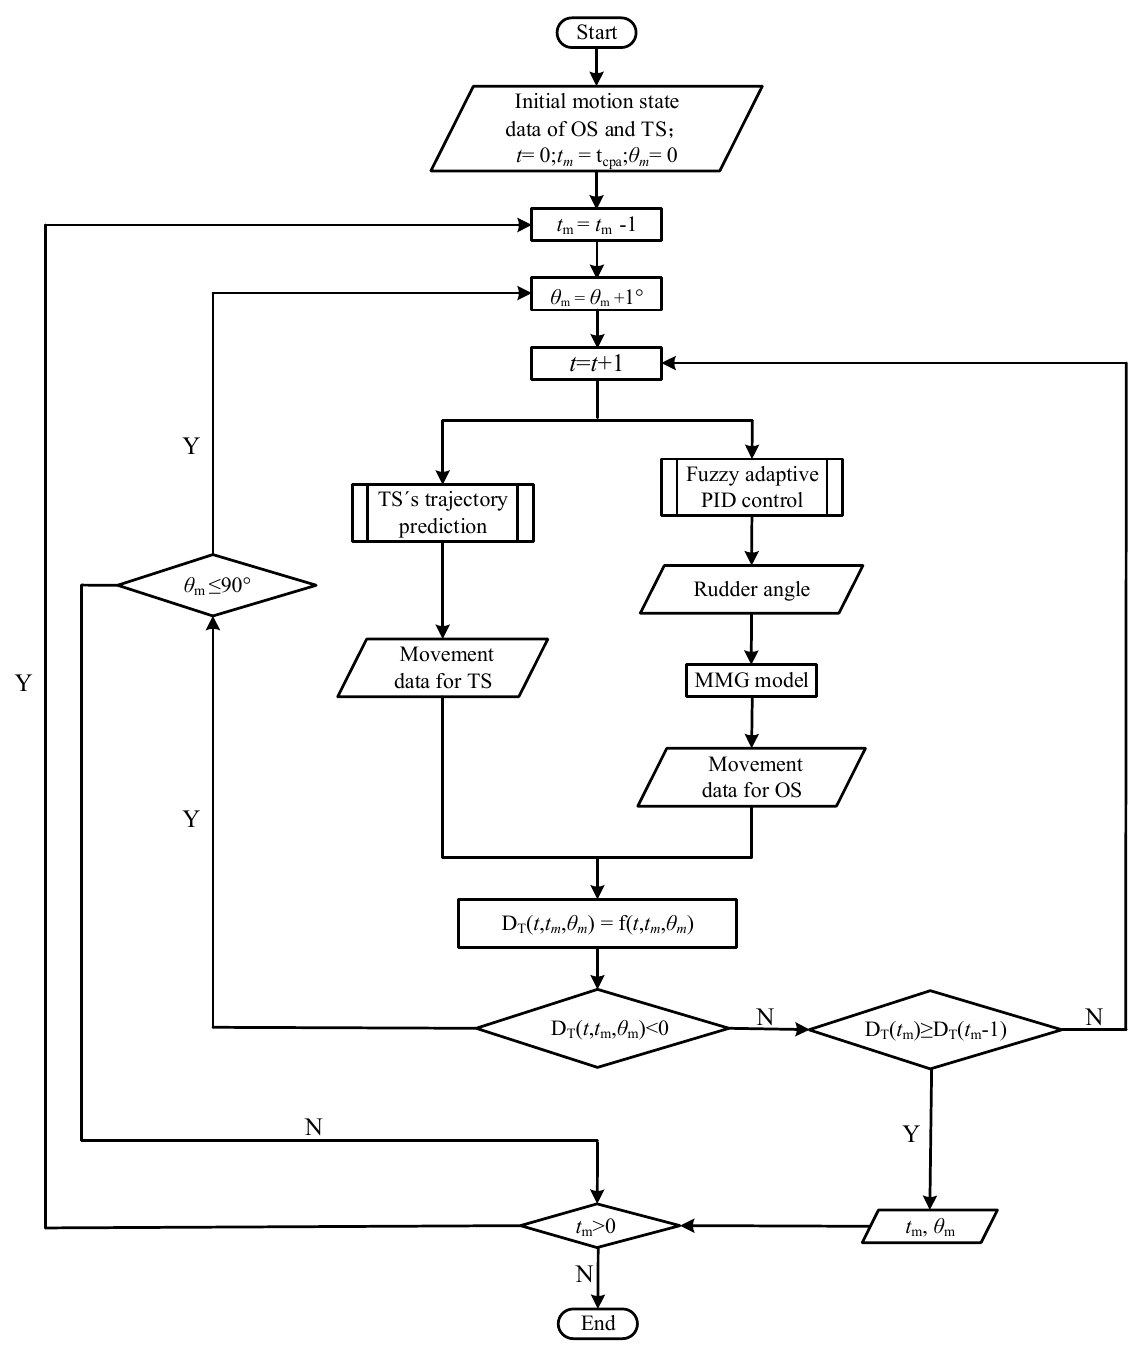
Figure 7. Numerical method of the minimum course-alteration angle based on time.